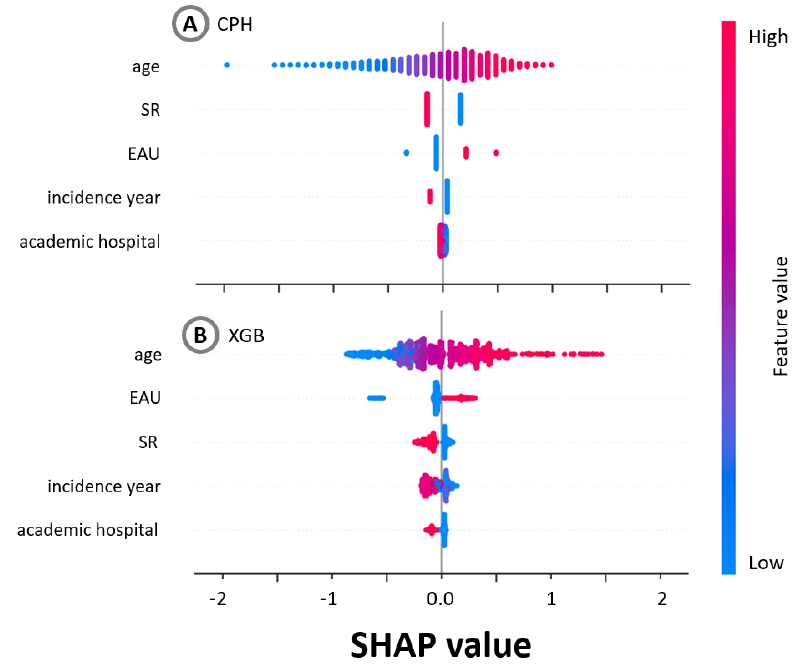
Figure 3. SHAP swarm plots of ( A ) CPH model and ( B ) XGB model. In each panel, features are arranged from top to bottom in decreasing order of importance. For each of them, each dot corresponds to a patient. Their location on the x -axis is determined by their SHAP value. Higher SHAP values correspond to a higher chance of death. The color indicates the value of the feature it represents and is depicted from low (blue) to high